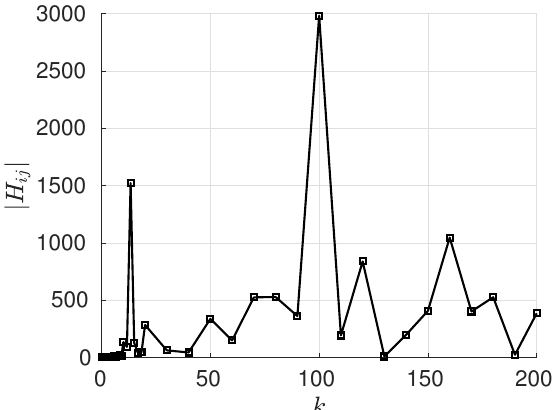
Figure 4. Typical element of the aerodynamic matrix transfer function (magnitude) against the reduced